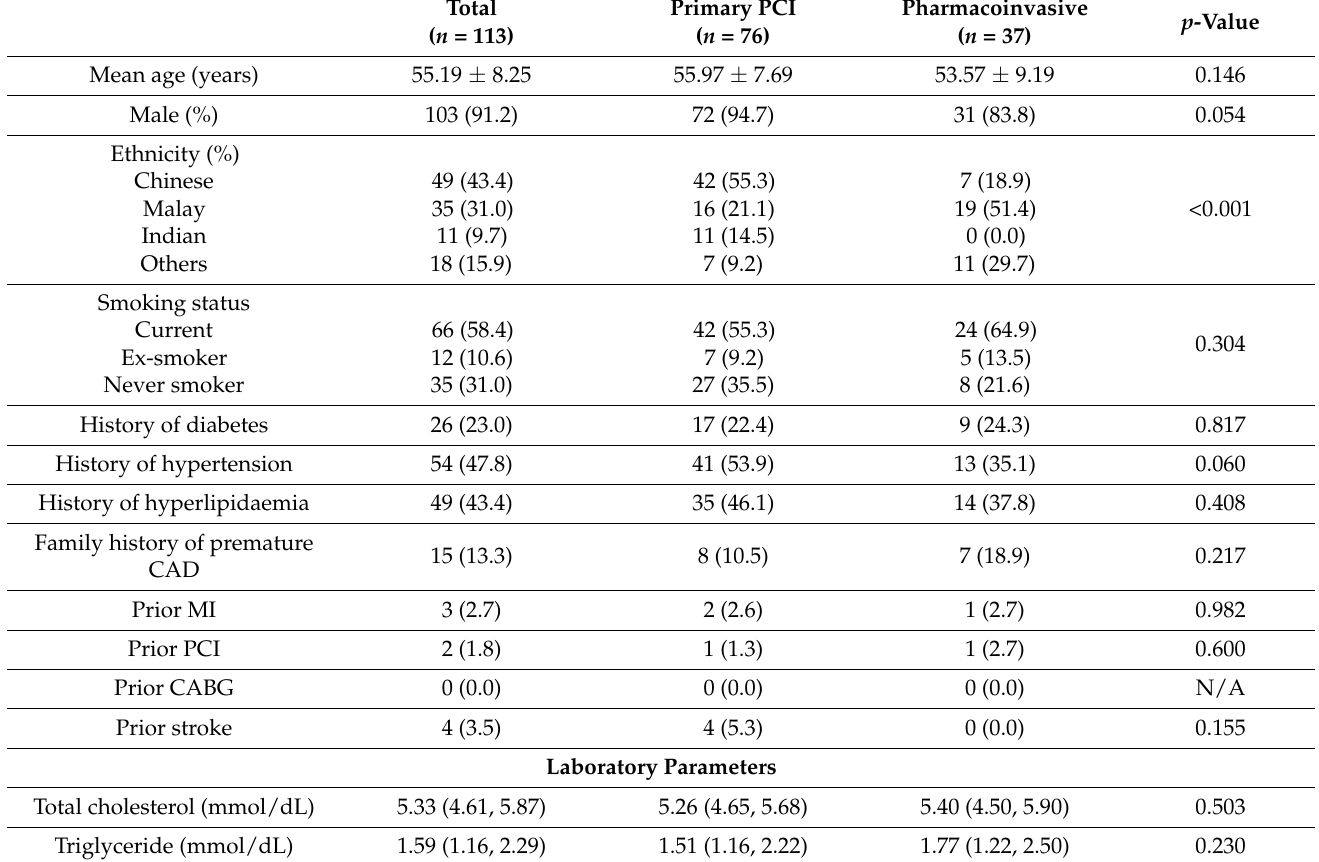
Table 1. Baseline characteristics of study